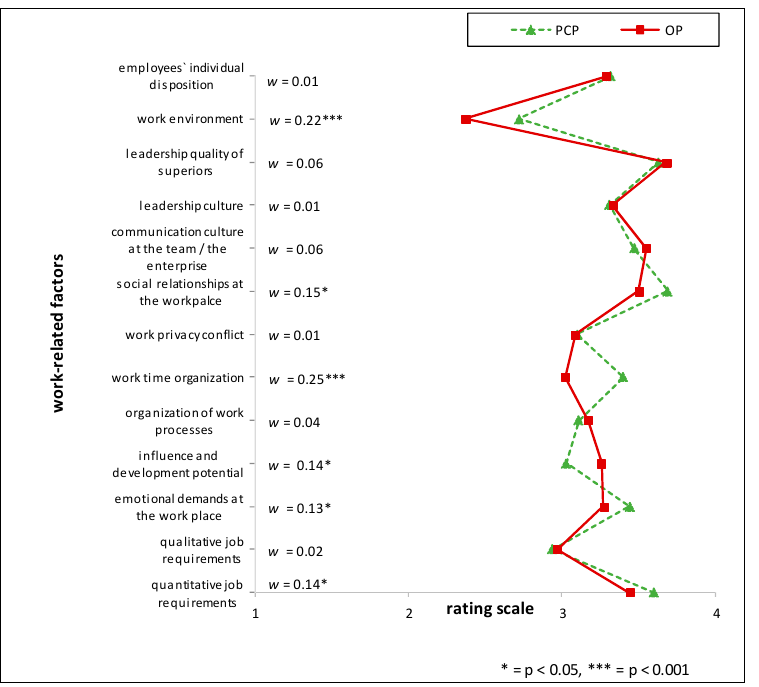
Figure 3. Polarity profile across work-related factors potentially important for (stress-associated) mental disorders in employees comparing the mean value ratings from “not at all important” (1) to “very important” (4) of Human Resource Managers (HRM) and Psychotherapists (PT), w = effect size of differences.